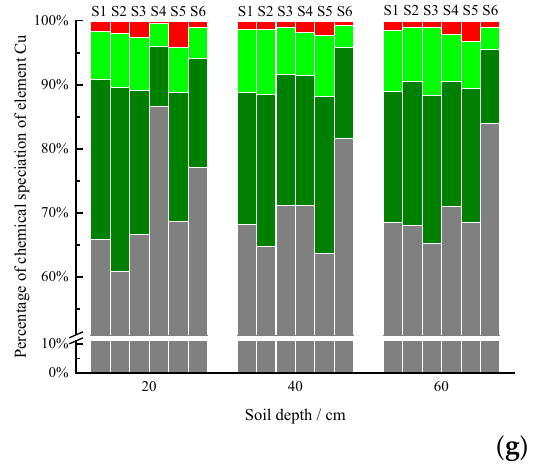
Table 5. K values (%) for heavy metals in the soil samples from An-tea